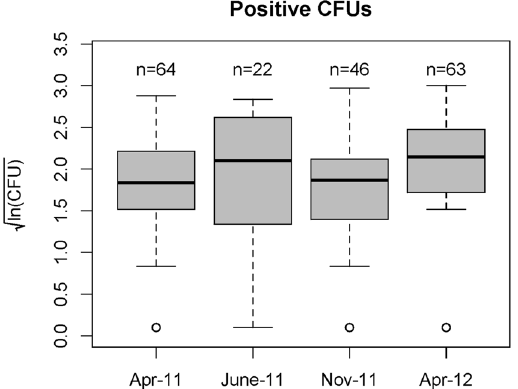
Figure 1. Quantitation of B. pseudomallei . Box-whisker plots log-transformed B. pseudomallei counts for each sampling round. The central horizontal line indicates the median value, and the upper and lower edges of boxes (hinges) correspond to the 25th and 75th percentile values, while the whiskers extend 1.5 × beyond the spread of the hinges. Data points outside this range (outliers) are indicated with circles.